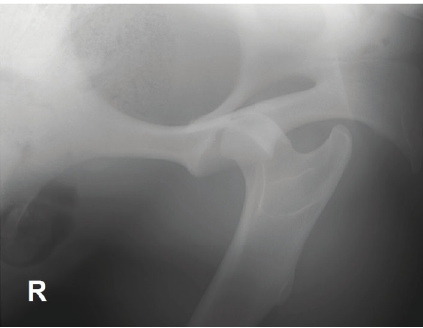
Figure 1: Ventrodorsal radiographic projection of the right acetabulum with complete dislocation of the right femoral head in a dorsal and caudal direction.